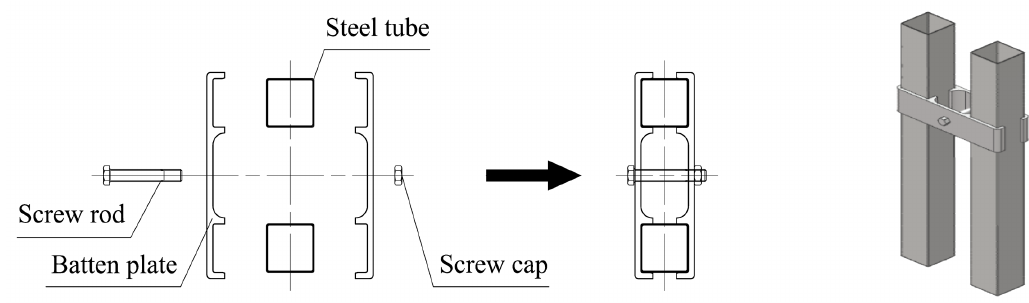
Figure 2. Installation of batten plates in the lattice column.